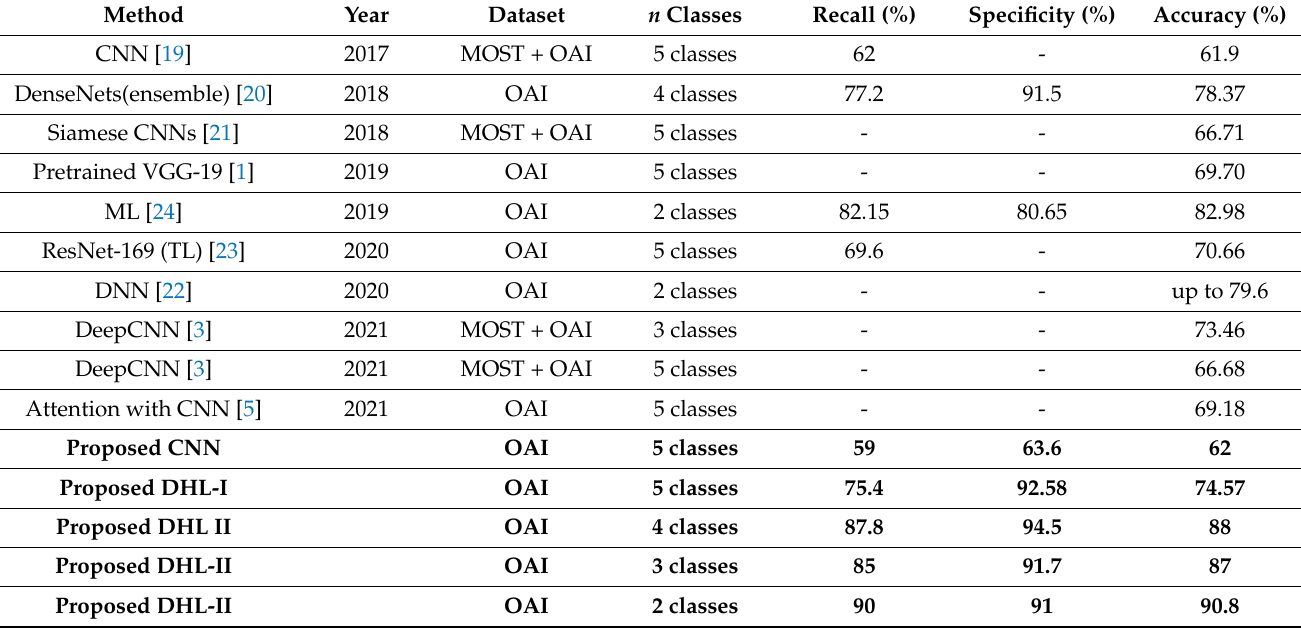
Table 9. Evaluation of the proposed method with other existing methods in terms of recall, specificity, and